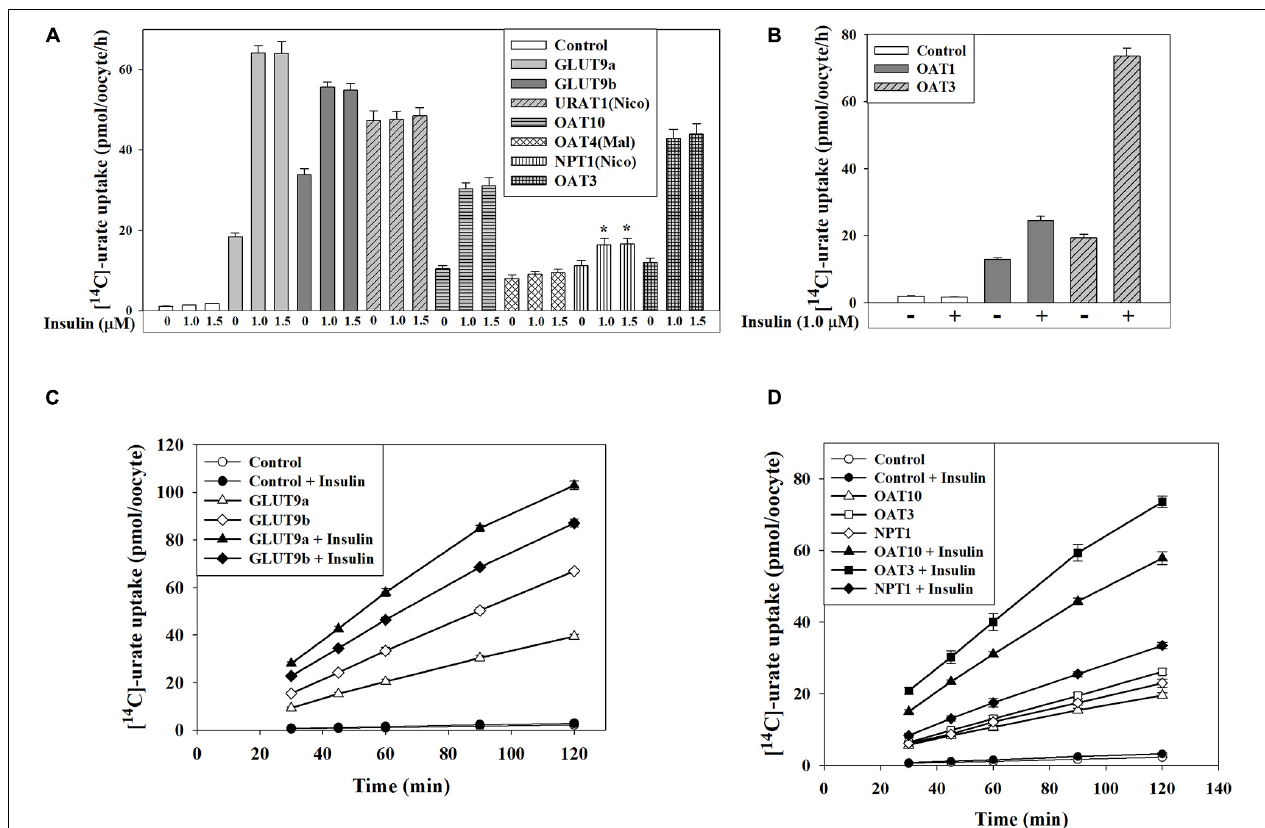
FIGURE 4 | Insulin stimulates urate transport mediated by GLUT9, OAT10, OAT1, mOAT3 or NPT1 expressed in Xenopus oocytes. (A,B) The [ 14 C]-urate uptake activity of human GLUT9 isoforms, URAT1, OAT10, OAT4, NPT1, OAT1, and mouse OAT3 was measured in absence and presence of insulin (1.0-1.5 µ M) in K + -free isotonic medium. (C,D) The time course plot of [ 14 C]-urate uptake mediated by human GLUT9a, GLUT9b, OAT10, NPT1 or mouse OAT3, expressed in oocytes, in the absence and presence of 1.0 µ M insulin. Oocytes expressing URAT1, OAT10 or NPT1 were preloaded with 50 nl of 100 mM nicotinate (Nico) and oocytes expressing OAT4 were preloaded with maleate (Mal) with 50 nl of 100 mM maleate by microinjection 2 h before urate uptake. Asterisk (*), P < 0.001 compared with urate uptake/efflux in the absence of